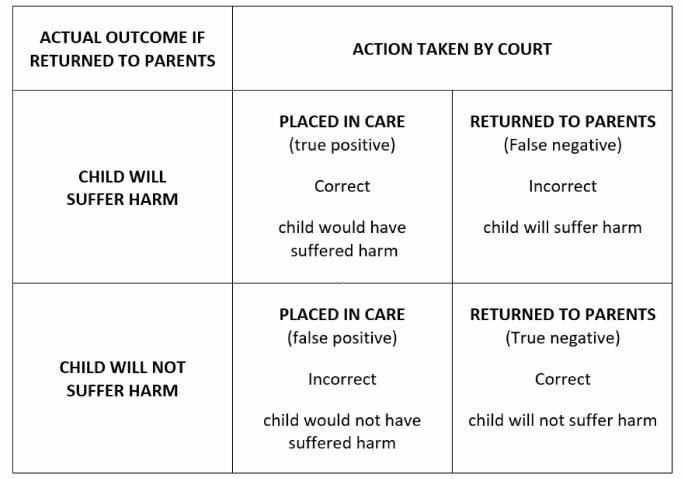
Figure 2. A fourfold table to consider prediction